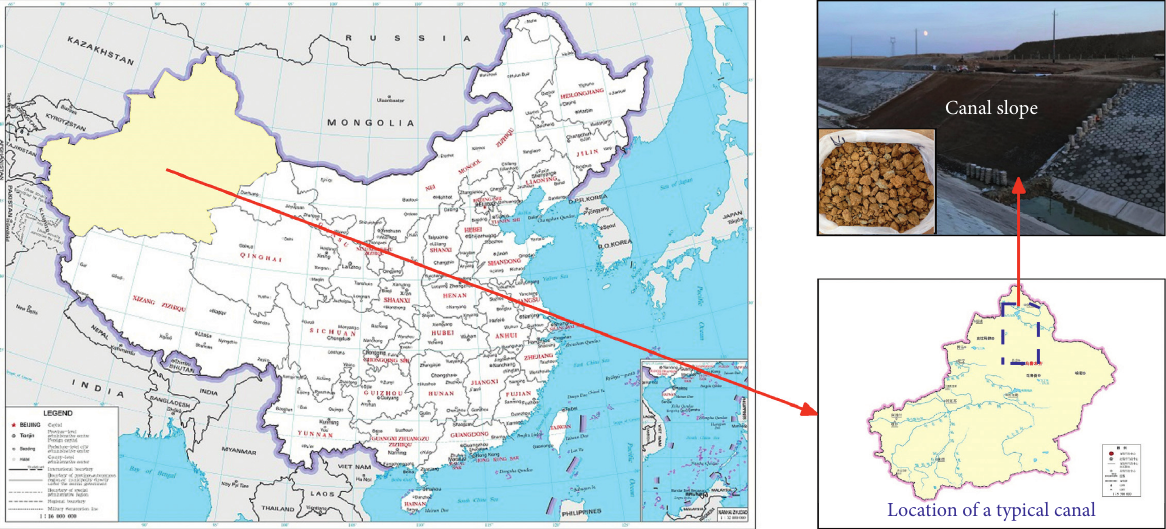
Figure 3: Location of the sampling area in Xinjiang, China.